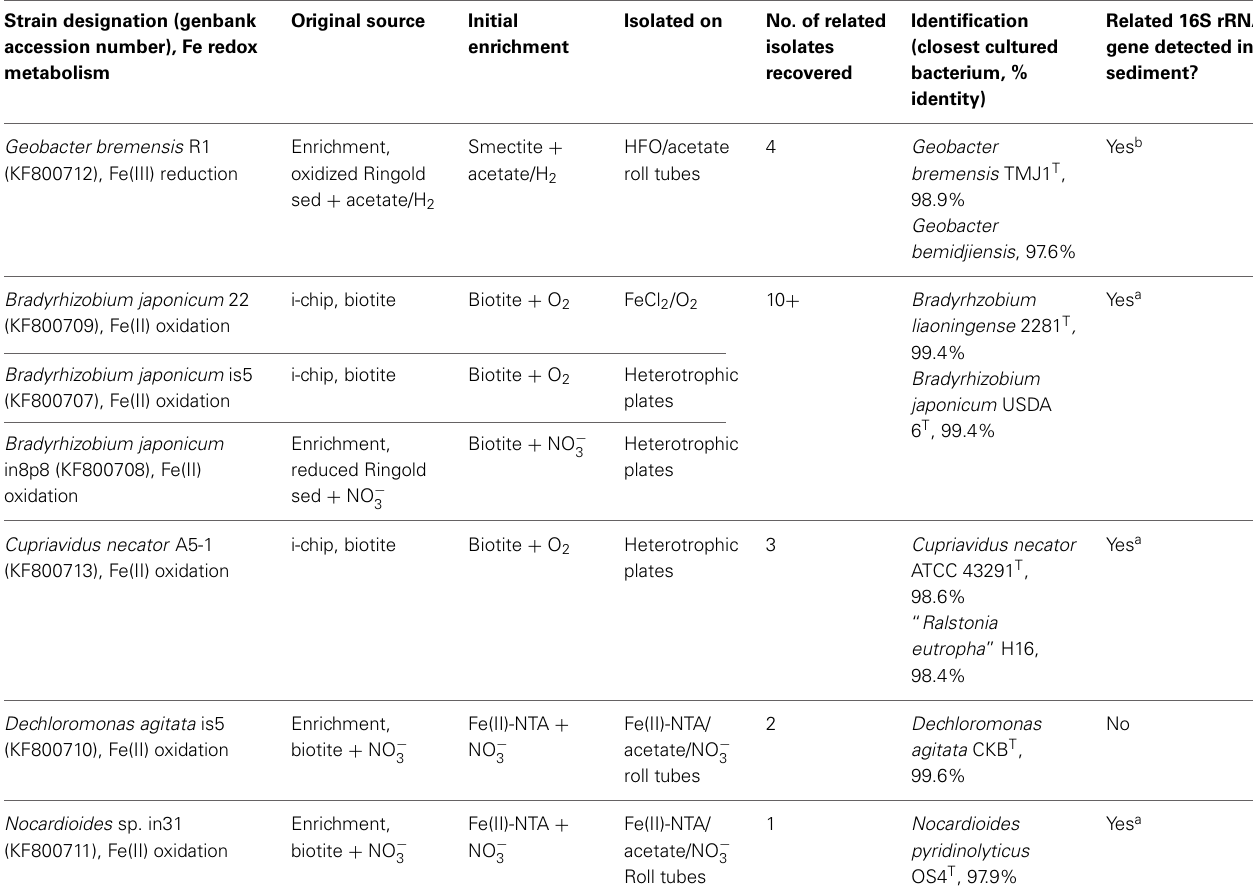
Table 4 | Fe redox cycling microorganisms isolated from Hanford 300